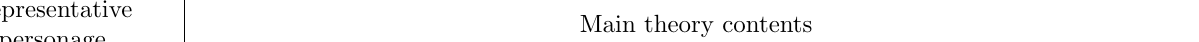
wall’s acoustic resonance frequency of the